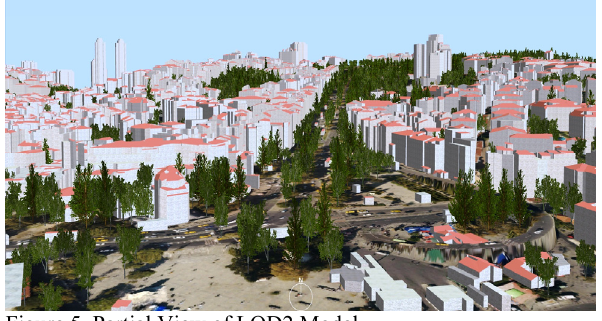
Figure 5. Partial View of LOD2